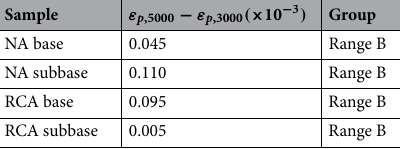
Table 3. Material classification based on Shakedown theory 48